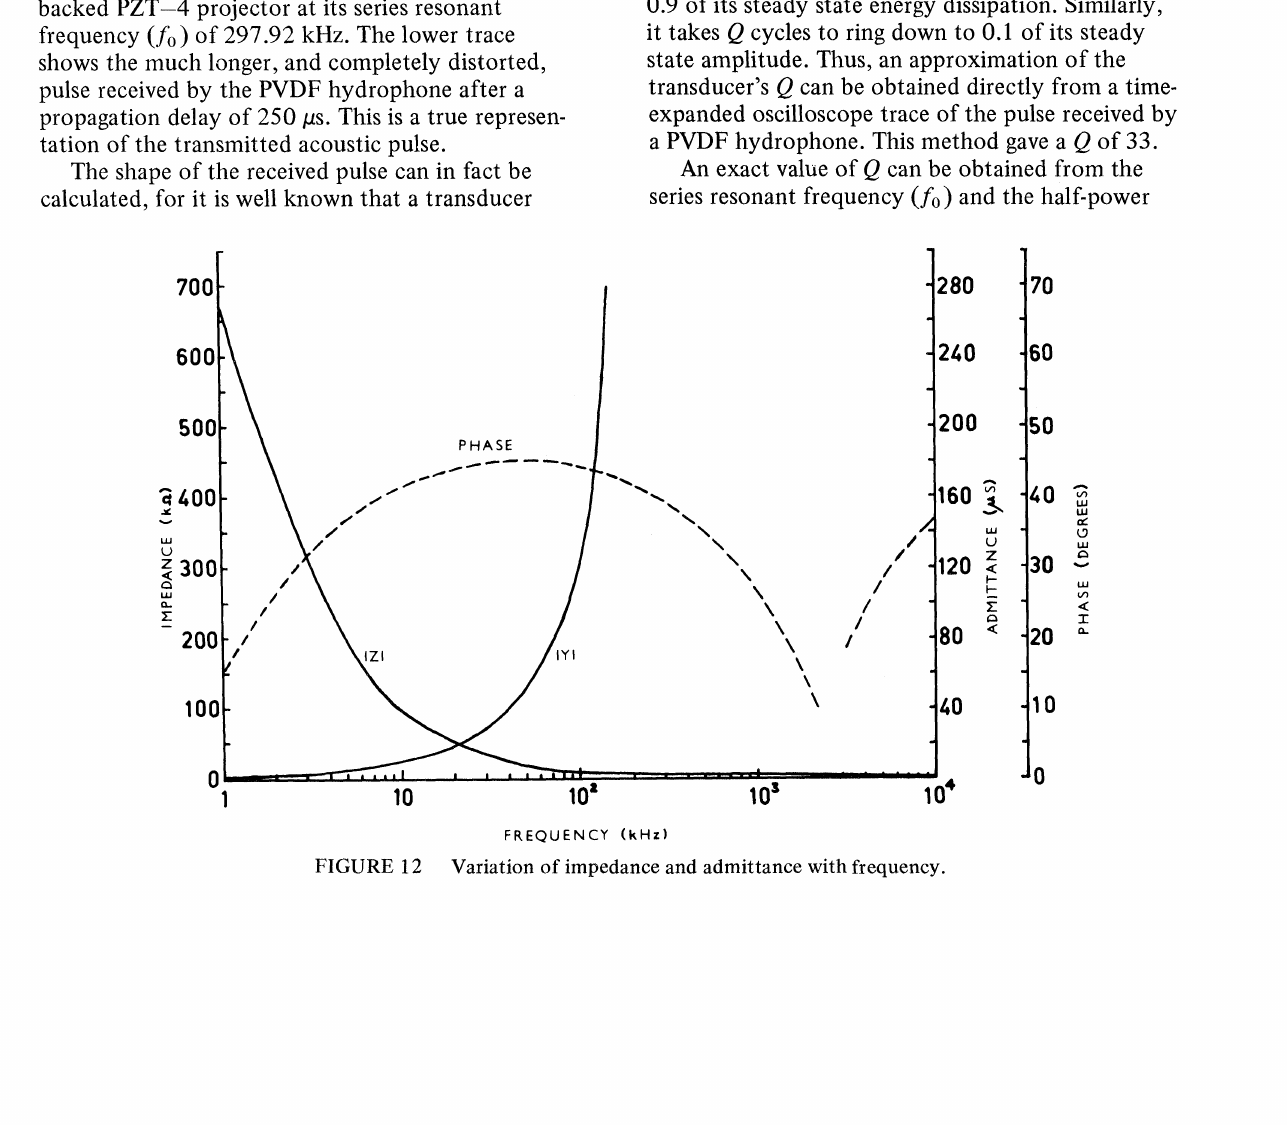
Variation of impedance and admittance with